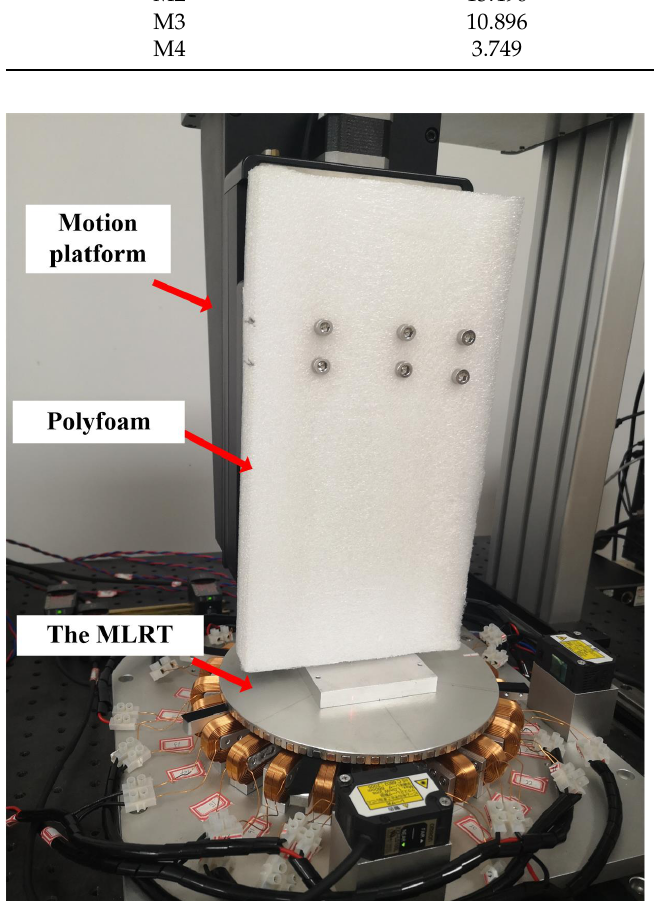
Figure 8. Photo of the MLRT with polyfoam producing unknown disturbance. Experimental video is found in the Supplementary Video